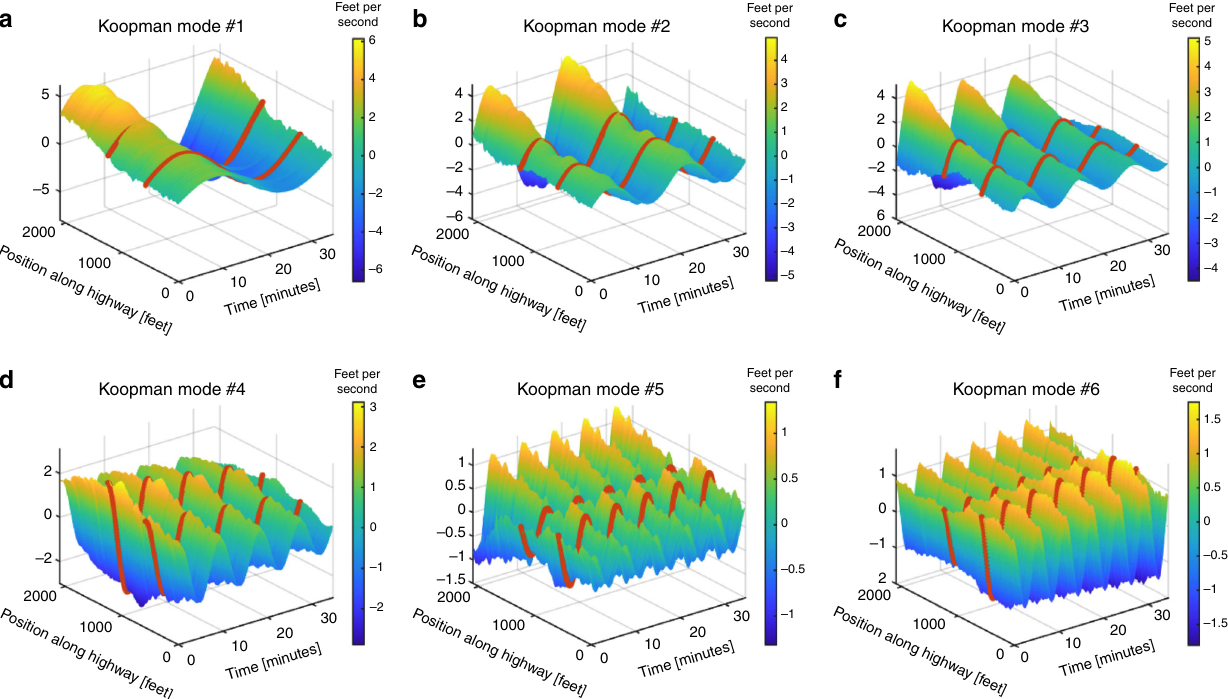
Fig. 2 Koopman modes demonstrating our method ’ s ability to uncover patterns hidden within traf fi c velocity data. The on/off-ramp locations have been labeled with dark orange dotted lines. Modes 1 – 3 have a very localized structure near the post-off-ramp section, indicating that they correspond to pinned localized clusters (PLC). Furthermore, it is evident that the fi rst three modes capture the general transition from high to low velocities that occurs during the onset of traf fi c. Mode 5 seems to be a spatial harmonic of the fi rst three modes in that it has another peaked structure in the mid-ramp section of the highway. Modes 4 and 6 provide clear evidence for the pumping effect, where an apparent increase in amplitude followed by a decrease can be seen in these modes as they propagate past the off and on-ramps respectively. Overall, the Koopman modes uncover complex spatiotemporal wave structures that are hidden within traf fi c data. Furthermore, every mode oscillates with a single known frequency, according to the imaginary part of its corresponding eigenvalue. This can be contrasted to a Fourier analysis which would yield modes and frequencies speci fi c to the positions along the highway. A complete list containing the periods of oscillation of the modes we discussed can be referenced in Supplementary Table